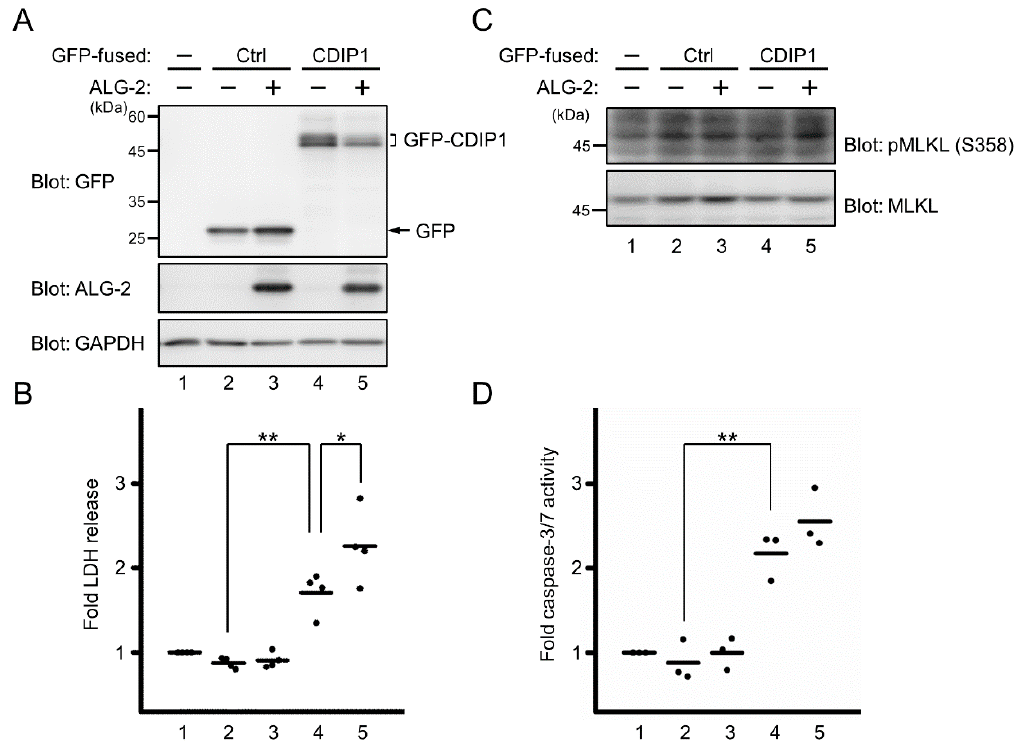
Figure 3. Promotion of CDIP1-induced cell death by ALG-2 expression. ALG-2 KO HEK293 cells were transfected with expression plasmids for GFP (Ctrl) or GFP-CDIP1 (CDIP1) in combination with or without expression plasmids for ALG-2. Mock-transfected cells were used as a reference to calculate the relative release of lactate dehydrogenase (LDH) and the intracellular caspase-3/7 activity. ( A ) Representative results of WB analysis of protein levels of GFP-CDIP1 (upper panel) and ALG-2 (middle panel) in cells at 40 h after transfection. GAPDH was detected as a loading control (lower panel). ( B ) Cell death was monitored by measuring the amounts of LDH released into the medium. Values are expressed as fold LDH release into the medium compared with that of mock-transfected cells. Four independent repetitive experiments were performed and data are expressed as dot plots with means (bar). Statistical significance by one-way ANOVA followed by Tukey’s test is indicated by asterisks (** p < 0.01 and * p < 0.05). ( C ) Representative results of WB analysis of protein levels of phosphorylated MLKL (upper panel) and total MLKL (lower panel) in cells at 40 h after transfection. ( D ) Caspase-3/7 activity was measured using the Caspase-3/7-Glo assay system at 40 h after transfection. Values are expressed relative to mock-transfected cells. Three independent repetitive experiments were performed and data are expressed as dot plots with means (bar). Statistical significance by one-way ANOVA followed by Tukey’s test is indicated by asterisks (** p < 0.01).